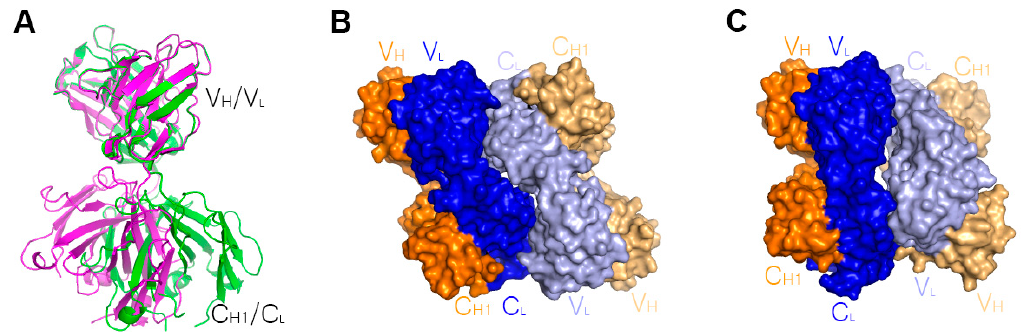
Figure 6. Self-association of infliximab mediated by the light chains. ( A ) An elbow rotation of Fab structures of ~40° in the I 2 1 2 1 2 1 (green) and C 222 1 (purple) forms indicates the flexibility between the variable (V H /V L ) and constant (C H1 /C L ) regions of the infliximab Fab.; ( B ) Head-to tail interaction mediated by the light chains of two Fab fragments in the I 2 1 2 1 2 1 form; ( C ) Head-to tail interaction mediated by the light chains of two Fab fragments in the C 222 1 form. In ( B , C ), the heavy chains are colored orange and pale orange, and the light chains are colored blue and pale blue.